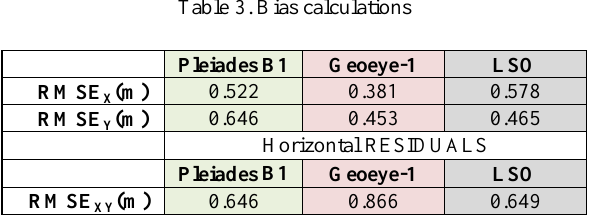
Table 4. RMSEs and horizontal residuals afters bias